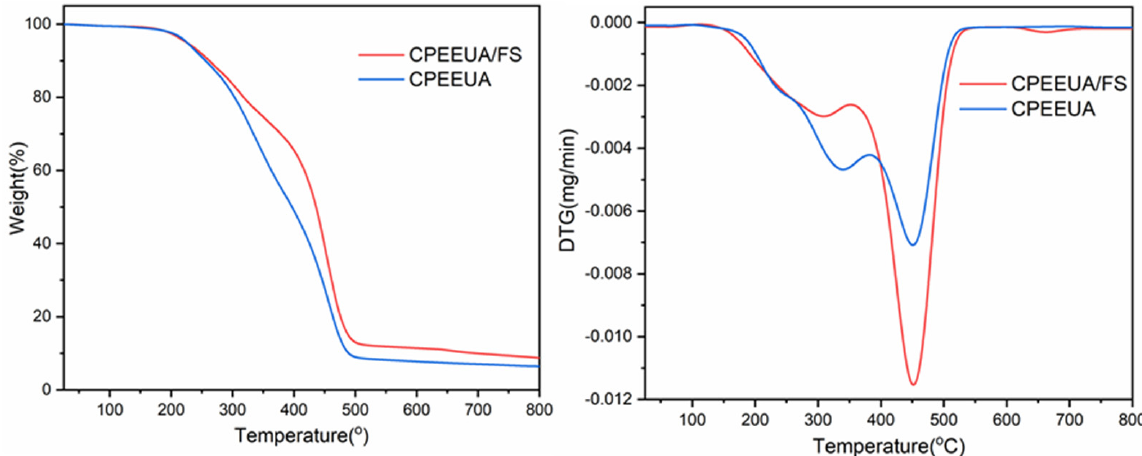
Figure 7. TGA and DTG of CPEEUA-40 and CPEEUA/FS-40 to compare their thermal stability.